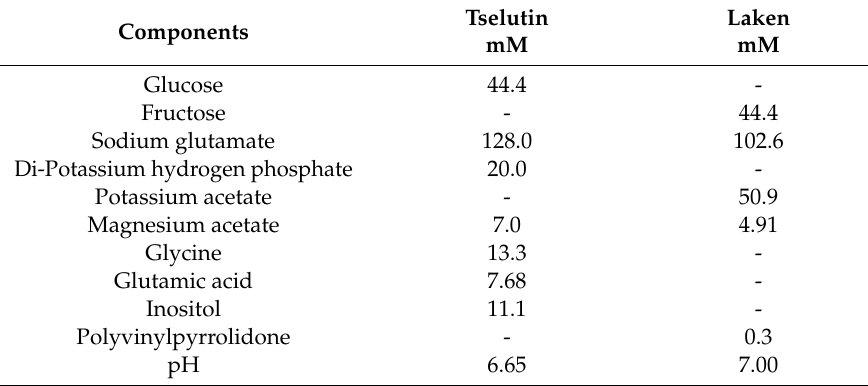
Table 1. Chemical composition of Tselutin and Lake